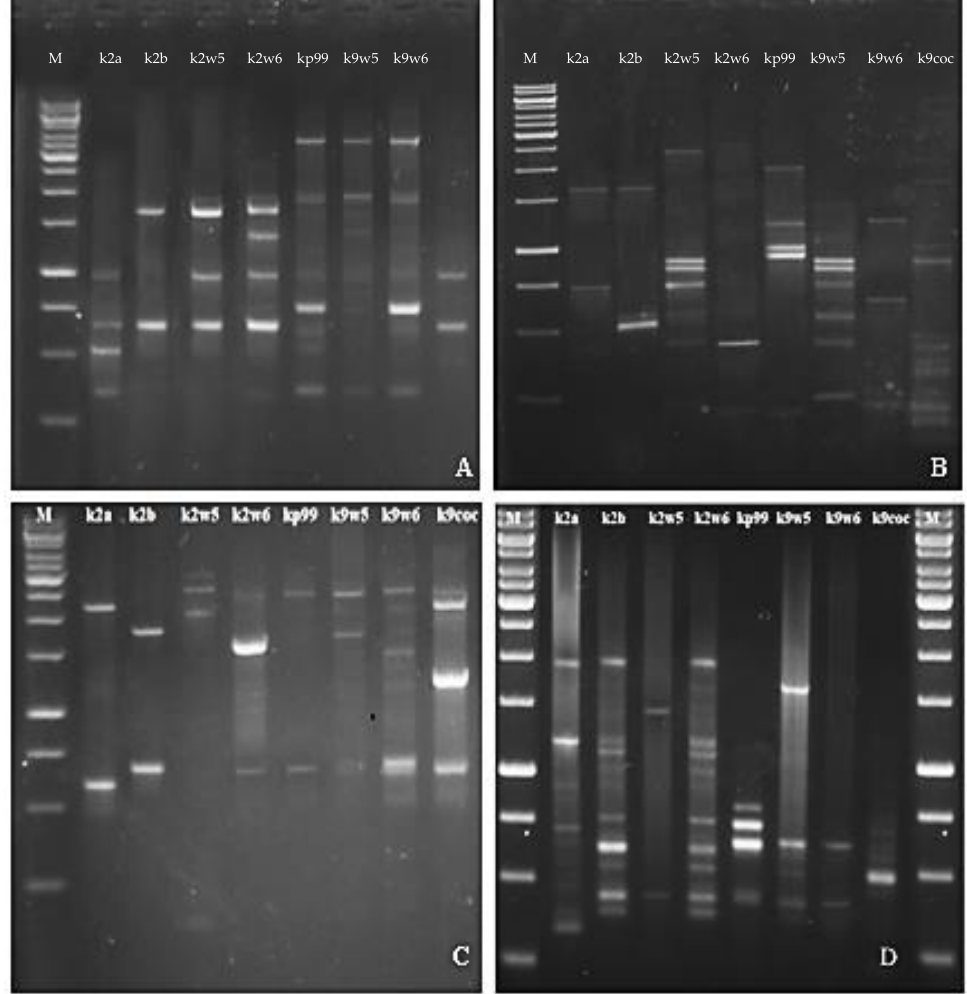
Figure 6. Agarose gel electrophoresis showing RAPD PCR amplification of DNA isolated from eight newly isolated K. pneumoniae phages with Primer ( A ) RAPD5, ( B ) R10, ( C ) RAPD2, ( D ) RAPD1.